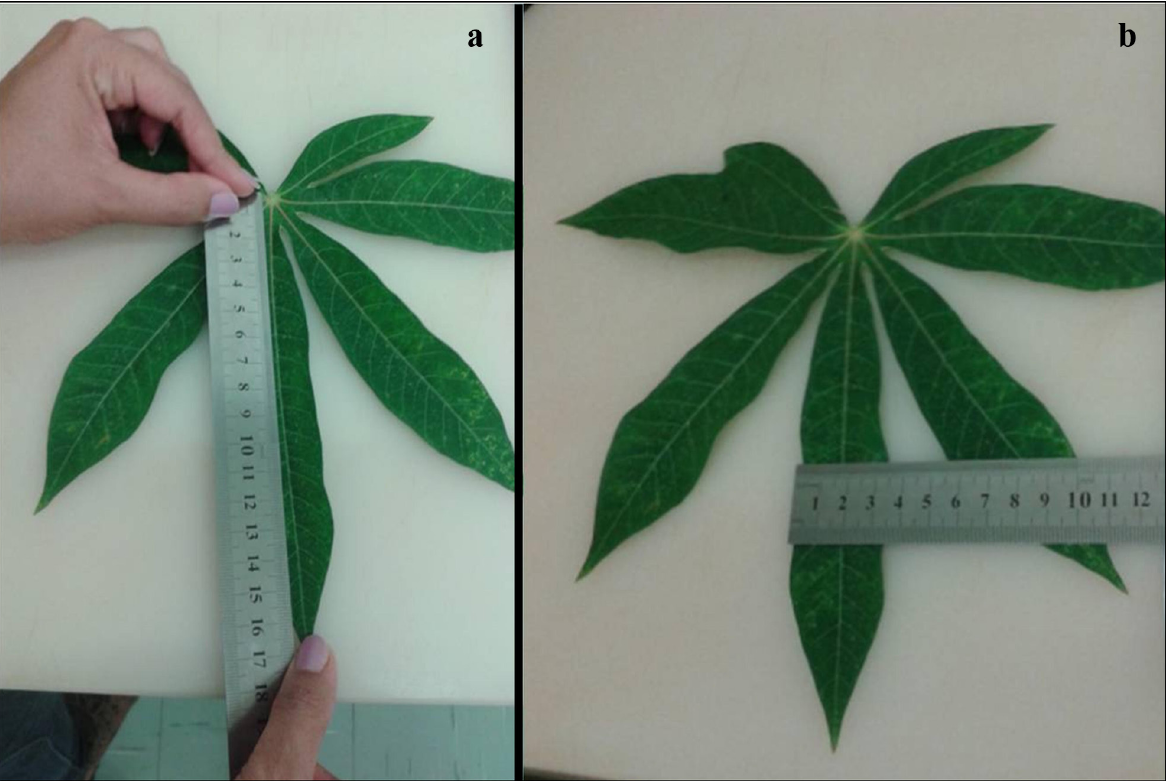
Figure 1 - Demonstration measurement length (a) and width (b) of the central lobe in cassava leaves IAC